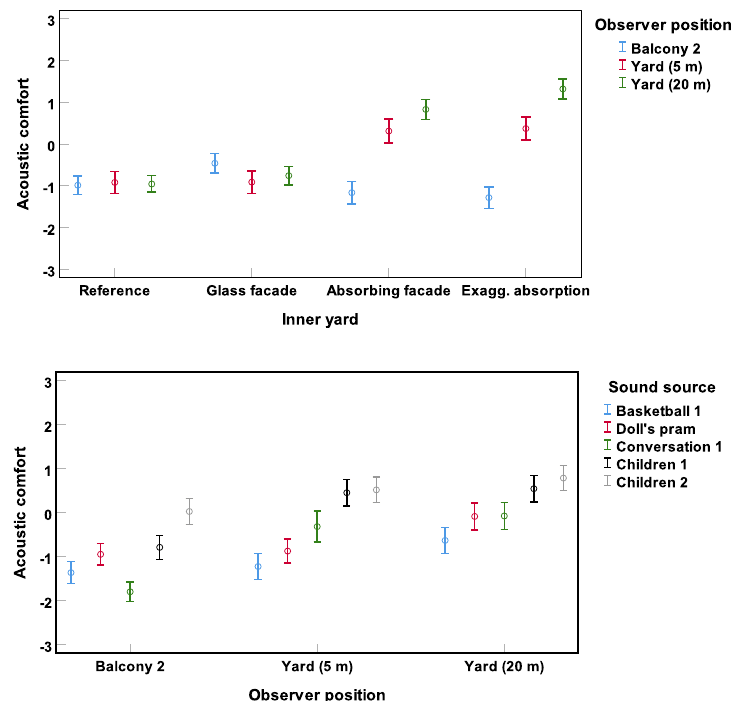
Figure 5. Significant interactions (Experiment 1) between inner yard and observer position ( above ) and between source and observer position ( below ). Mean acoustic comfort ratings across subjects and their 95% confidence intervals are